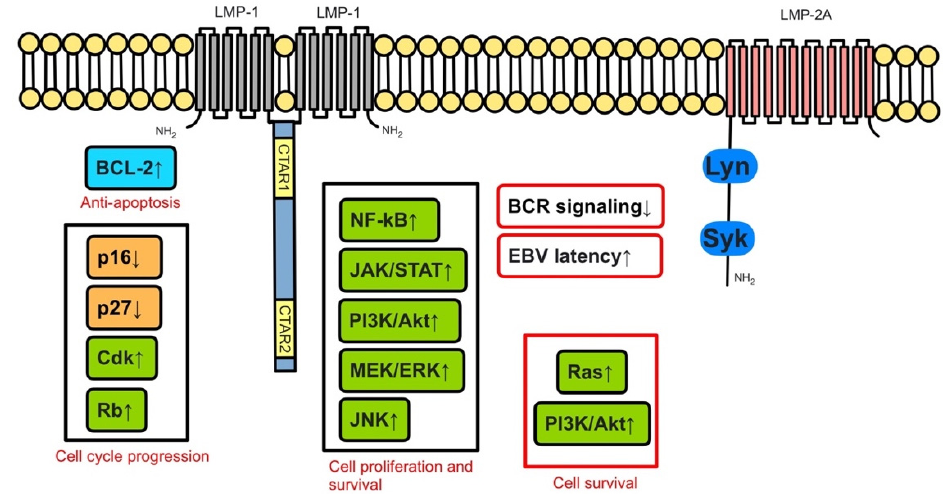
Figure 1. LMP-1, LMP-2A and downstream pathways in EBV-infected cells. Adapted from Ok, C., Li, L. & Young, K. EBV-driven B-cell lymphoproliferative disorders: from biology, classification and differential diagnosis to clinical management. Exp Mol Med 47, e132 (2015).